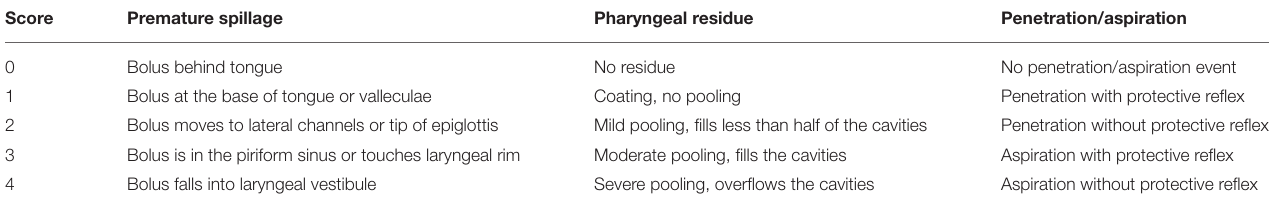
TABLE 3 | Scores of swallowing function parameters (71).